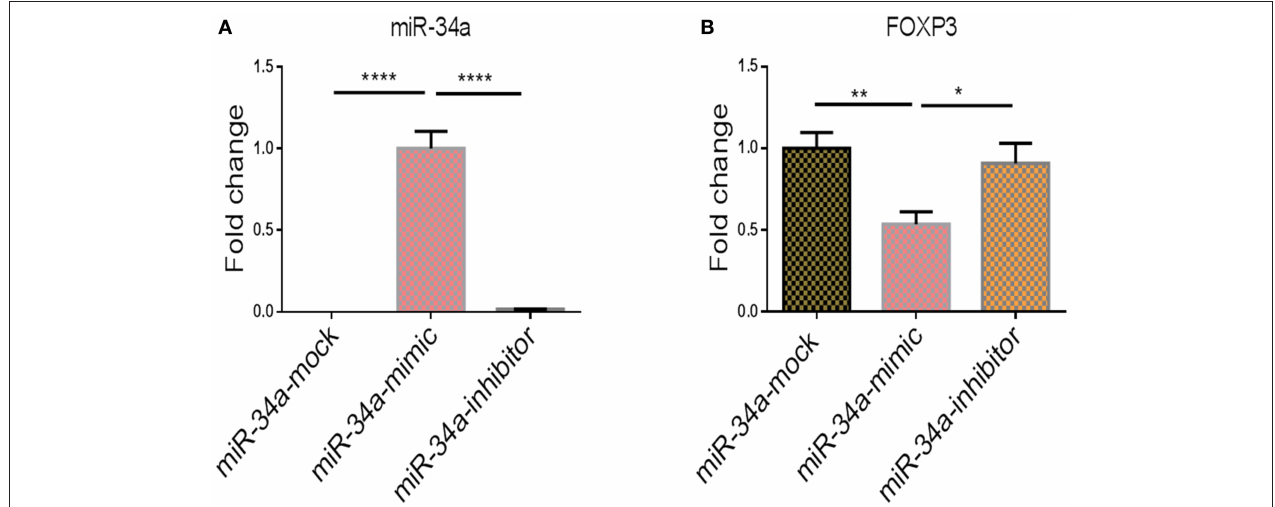
FIGURE 6 | The effect of transfection of miR-34a mimic and inhibitor on Foxp3 gene expression. qPCRs were performed to determine the expression of miR-34a and FoxP3 post transfection of splenocytes with miR-34a mimic and miR-34 inhibitor. (A) Shows the expression of miR-34a and (B) shows the expression of FoxP3 in splenocytes post transfection. The data presented as vertical bars represent Mean + /– SEM of triplicates. Significance (* p < 0.05, ** p < 0.01, **** p < 0.0001) of miR-34a and FoxP3 expression was determined using ANOVA test and Tukey’s-hoc